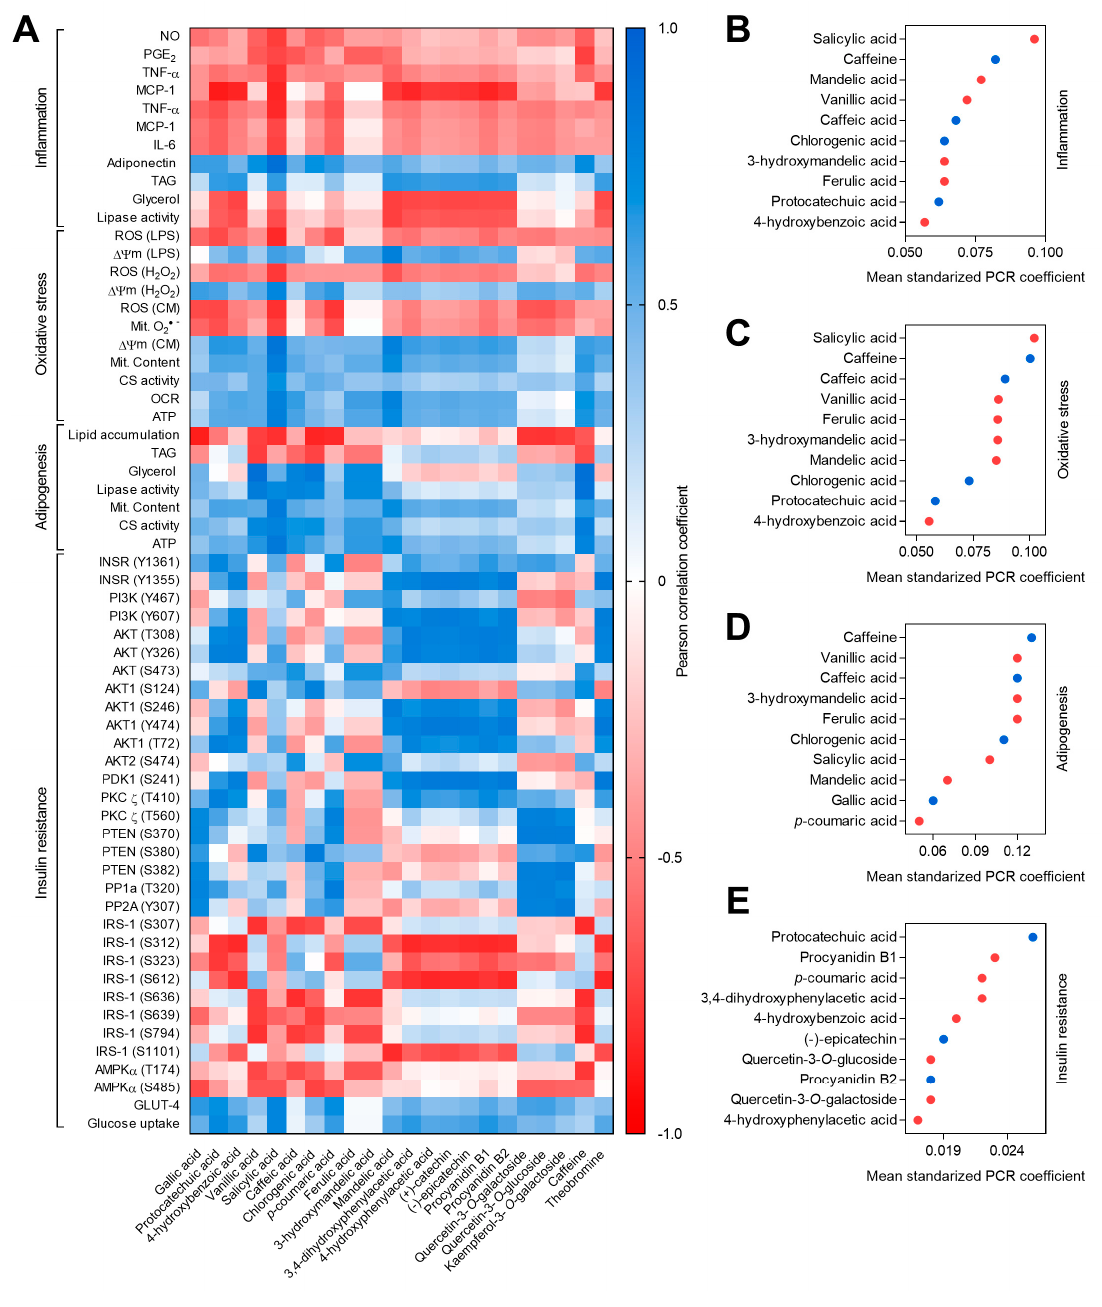
Figure 1. Heat map of the Pearson correlation coefficient established among observed in vitro effects and the concentration of different phytochemicals in coffee and cocoa by-products ( A ) and the top ten mean standardized principal component regression (PCR) coefficients of the regression constructed among the phytochemicals identified in coffee husk, coffee silverskin, and cocoa shell aqueous extracts and the potential of the extracts in the different biomarkers of inflammation ( B ), oxidative stress ( C ), adipogenesis ( D ), and insulin resistance ( E ). Blue ( ) and red ( ) circles indicate major (one of the ten in higher concentration) and minor phytochemicals, respectively.